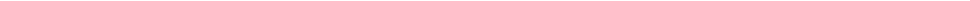
Figure 1: Privacy preserving approach for record linkage and blinded analysis in 136 consenting STCS renal transplant recipients from the transplant centre Basel. All participating institutions are shown with their respective available data. The blue boxes show which data were ex- changed at the patient individual level. The red boxes show the exchange of the analysis script or the analysis report. Data were exchanged in an encrypted way. CTU Basel provided the necessary infrastructure and instructions for further data transmissions. At CTU Basel, data were stored locally only in encrypted form. Any access to data is regulated and documented individually. SSSN: Swiss social security number (AHV number: Alters- und Hinterbliebenen Versicherung Nummer); CTU: clinical trial unit; ID: identity; STCS: Swiss Transplantation Cohort